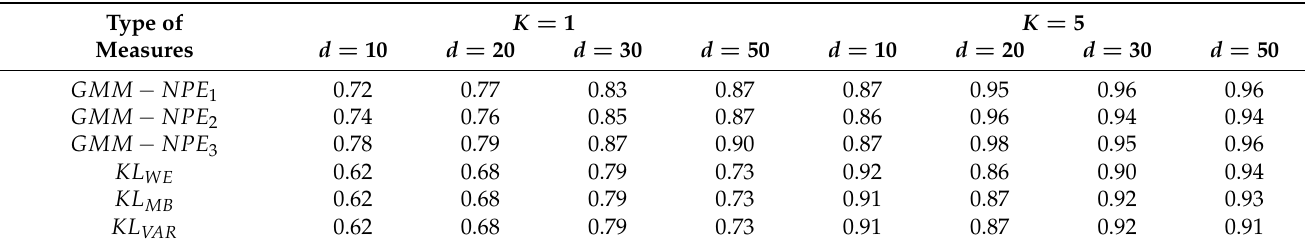
Table 1. Results in the form of recognition accuracy, obtained on the synthetic data: l = 1, t ∈ [ − 3,5 ] , N = 800, M = 200, m 1 , m 2 = 0.